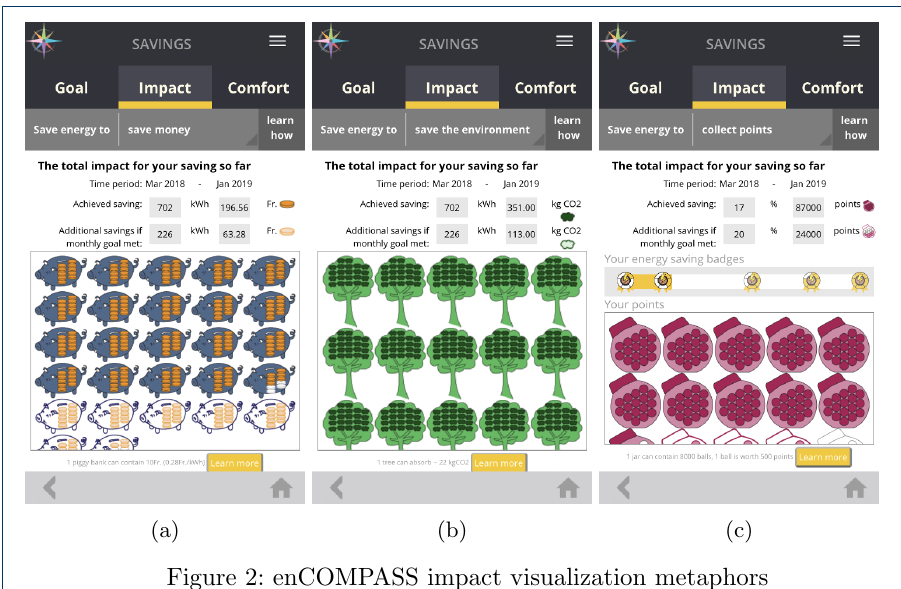
Figure 2: enCOMPASS impact visualization